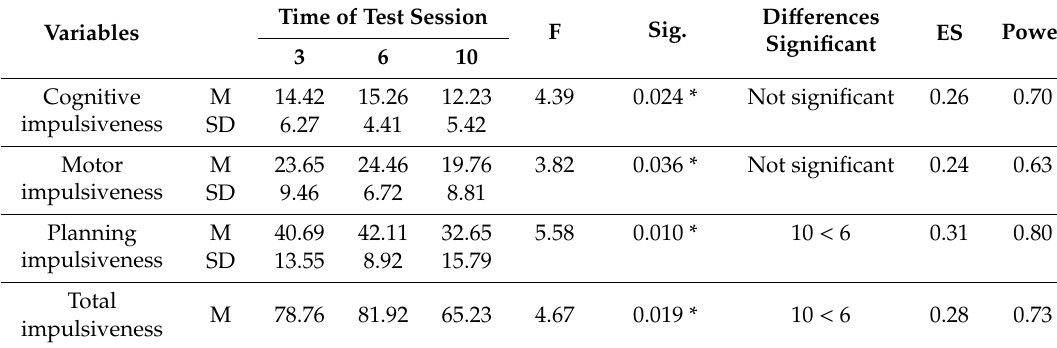
Table 4. Barratt Impulsiveness scale (BIS-11)